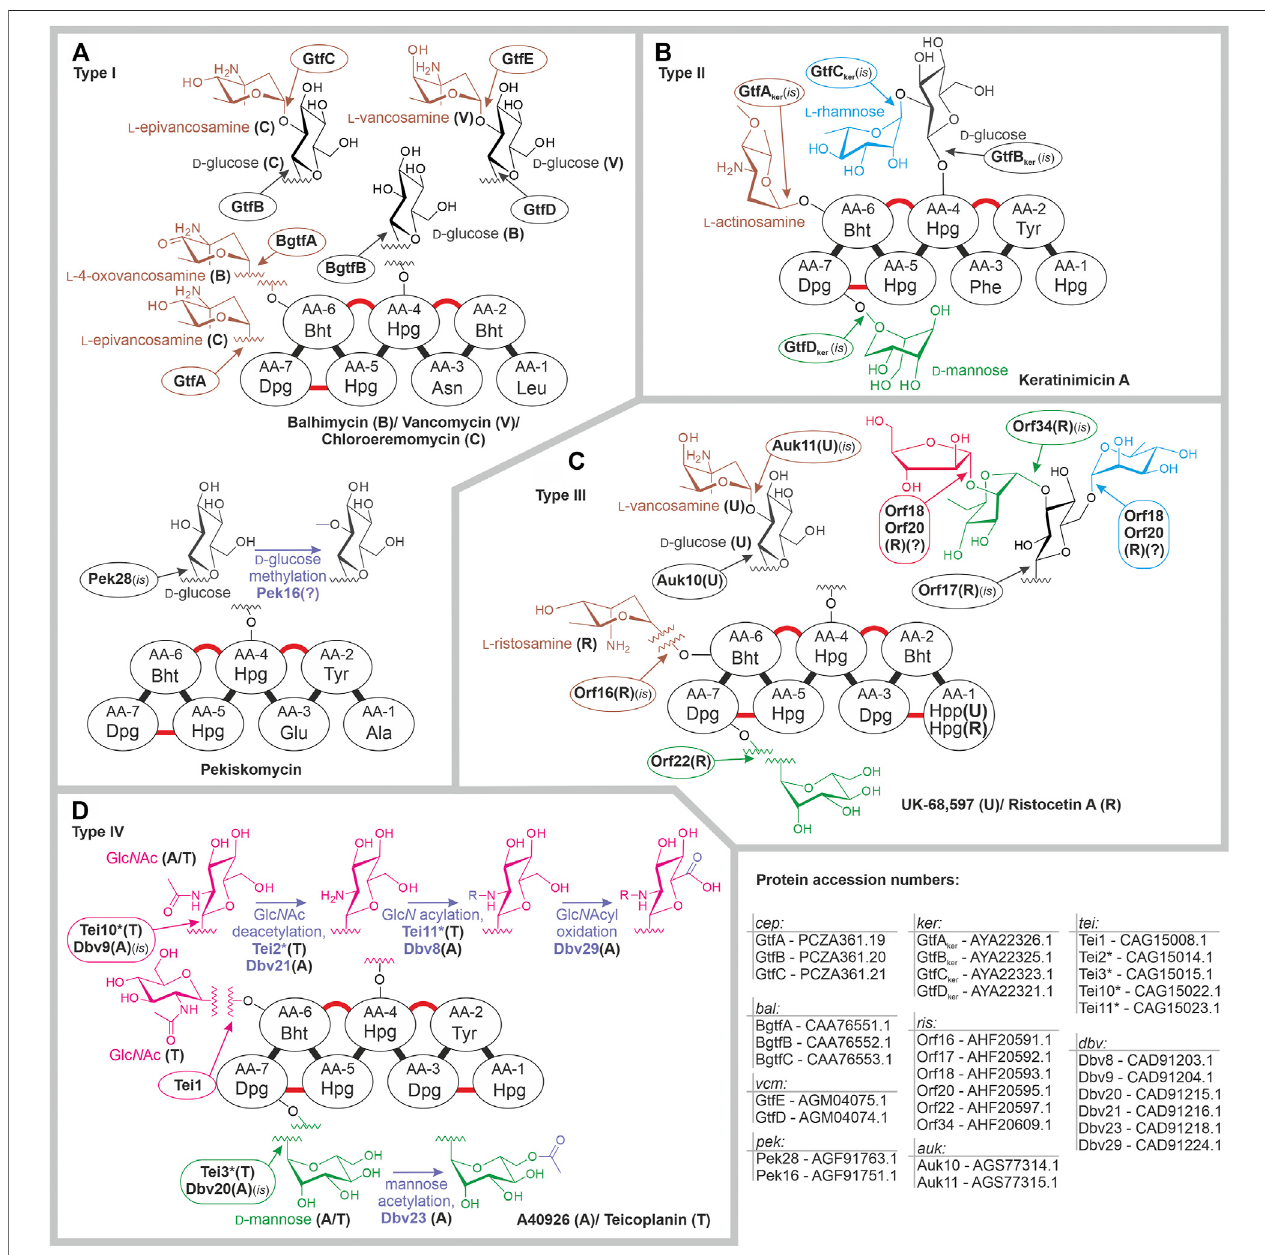
FIGURE 2 | Glycosylation patterns of type I (A) , type II (B) , type III (C) , and type IV (D) dalbaheptides and enzymes involved therein. Refer to the main text for more details. Dalbaheptide aglycones are depicted schematically with cross-links shown in red, and chlorination and sulfation sites are not shown. Aglycone amino acid abbreviations mean following: Leu-leucine; Asn-asparagine; Ala-alanine; Glu-glutamine; Phe-phenylalanine; Tyr-tyrosine; Bht- ß -hydroxytyrosine; Dpg-3,5- dihydroxyphenylglycine; Hpg-4-hydroxyphenylglycine; Hpp-4-hydroxyphenypyruvate; Tyr-. Glc N stated for N- glucosamine, GlcNAcyl for N-acylglucosamine. All enzymes,whosefunctionswereassignedby insilico comparisonaremarkedwith( is );(?)indicatesthatfunctionwasassigned insilico withoutexperimentallyinvestigated prototype or exact function remains unknown. For fast access to protein sequences mentioned in this fi gure, use following links: cep : GtfA-PCZA361.19, GtfB- PCZA361.20, GtfC-PCZA361.21; bal : BgtfA-CAA76551.1, BgtfB-CAA76552.1, BgtfC-CAA76553.1; vcm : GtfE-AGM04075.1, GtfD-AGM04074.1; pek : Pek28- AGF91763.1, Pek16-AGF91751.1; ker : GtfA ker -AYA22326.1, GtfB ker -AYA22325.1, GtfC ker -AYA22323.1, GtfD ker -AYA22321.1; ris : Orf16-AHF20591.1, Orf17- AHF20592.1,Orf18-AHF20593.1,Orf20-AHF20595.1;Orf22-AHF20597.1,Orf34-AHF20609.1; auk :Auk10-AGS77314.1,Auk11-AGS77315.1; tei :Tei1-CAG15008. 1, Tei2*-CAG15014.1, Tei3*-CAG15015.1, Tei10*-CAG15022.1, Tei11*-CAG15023.1; dbv : Dbv8-CAD91203.1, Dbv9-CAD91204.1, Dbv20-CAD91215.1, Dbv21- CAD91216.1, Dbv23-CAD91218.1, Dbv29-CAD91224.1.